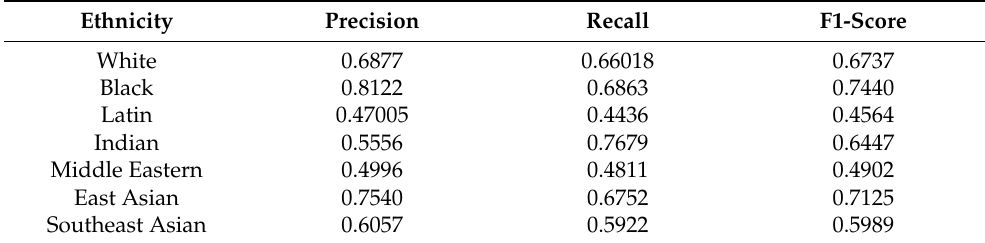
Table 13. Results for the FairFace filtered testing without plotted landmarks.